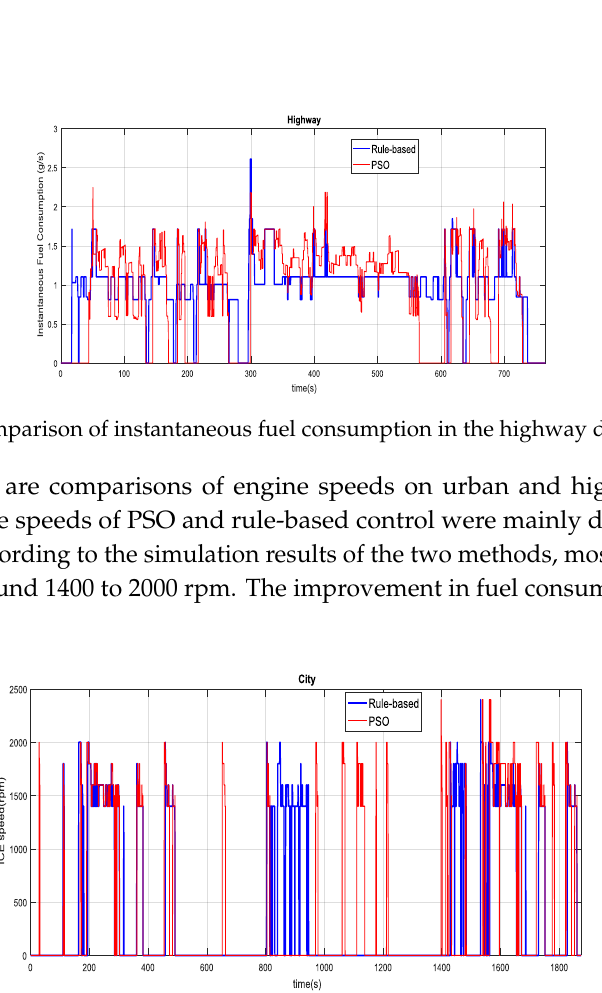
Figure 10. Comparison of instantaneous fuel consumption in the urban driving cycle.